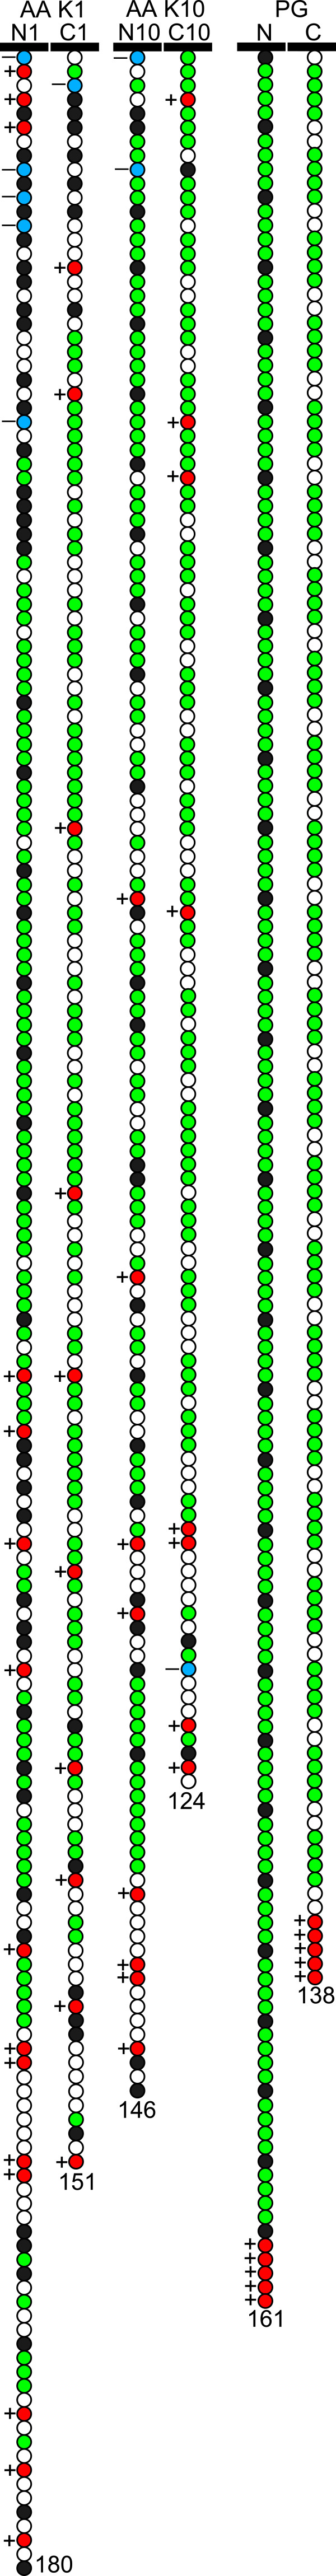
Models of unstructured domains. Schematic illustration of the N and C unstructured terminal domains for the AA and PG models. Colour code: white - “P”; black - “H”; red - “+”; blue - “–”, green - “G”.